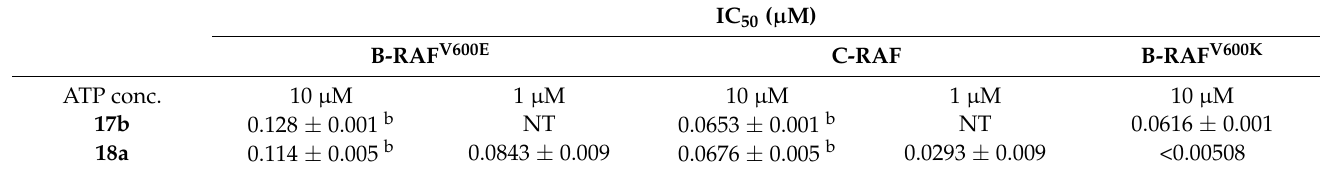
Table 2. In vitro kinase inhibitory activity (IC 50 , µ M) of the most potent compounds, 17b and 18a , against B-RAF V600E/V600K and C-RAF a,b,c